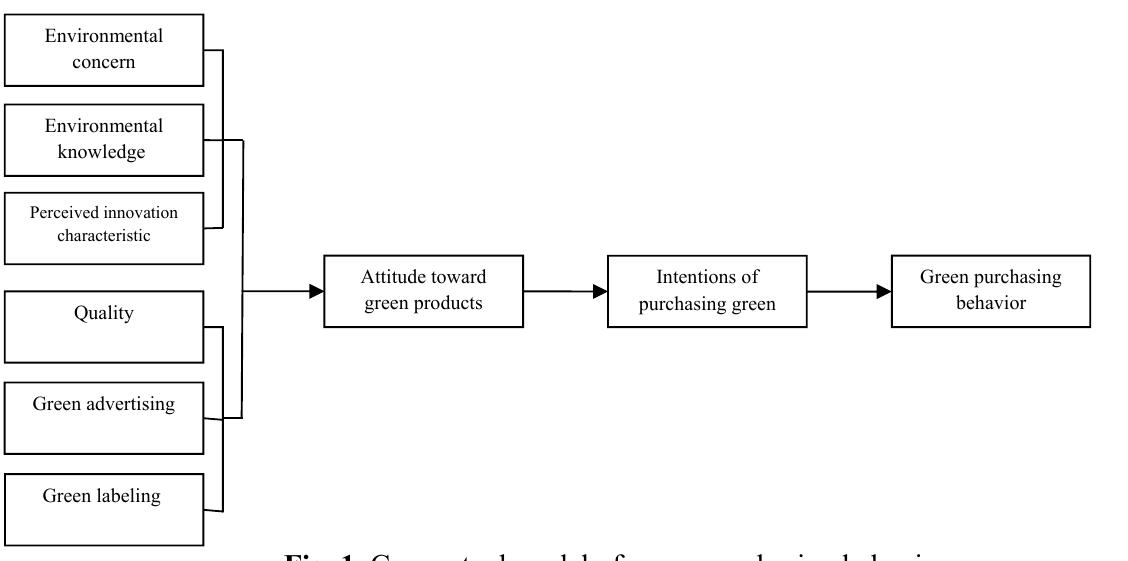
Fig. 1. Conceptual model of green purchasing